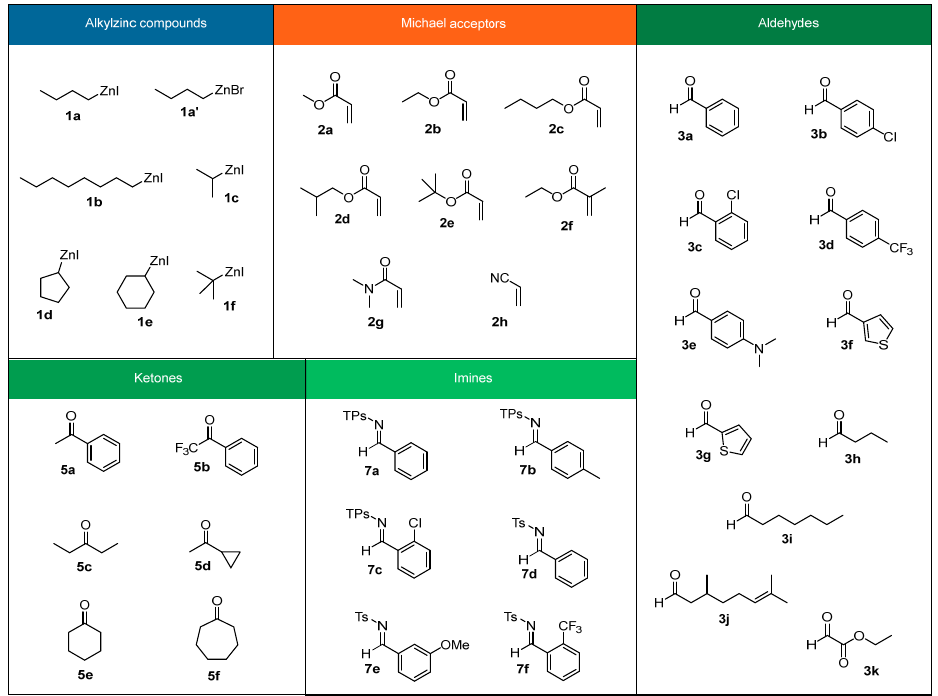
Figure 1. Classes of compounds used in the multicomponent reaction. Ts = toluenesulfonyl, TPs = 2-thiophenesulfonyl.